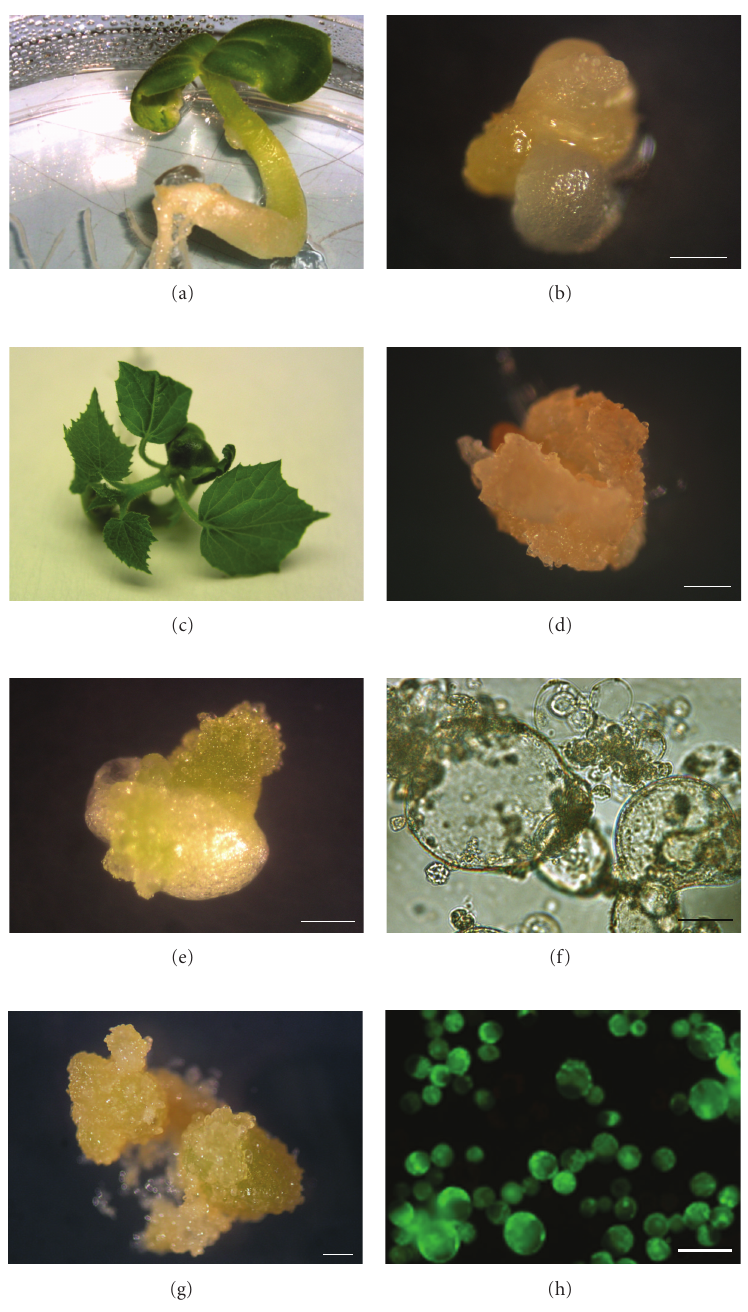
Figure 3: (a) Cucumber mixoploid (2x/4x) seedling after in vitro polyploidization by oryzalin. (b) C. sativus (2x) × C. melo microcallus after in vivo pollination. (c) C. sativus (2x/4x) × C. melo plant after in vivo pollination. (d) C. sativus (2x) × C. melo microcallus after in